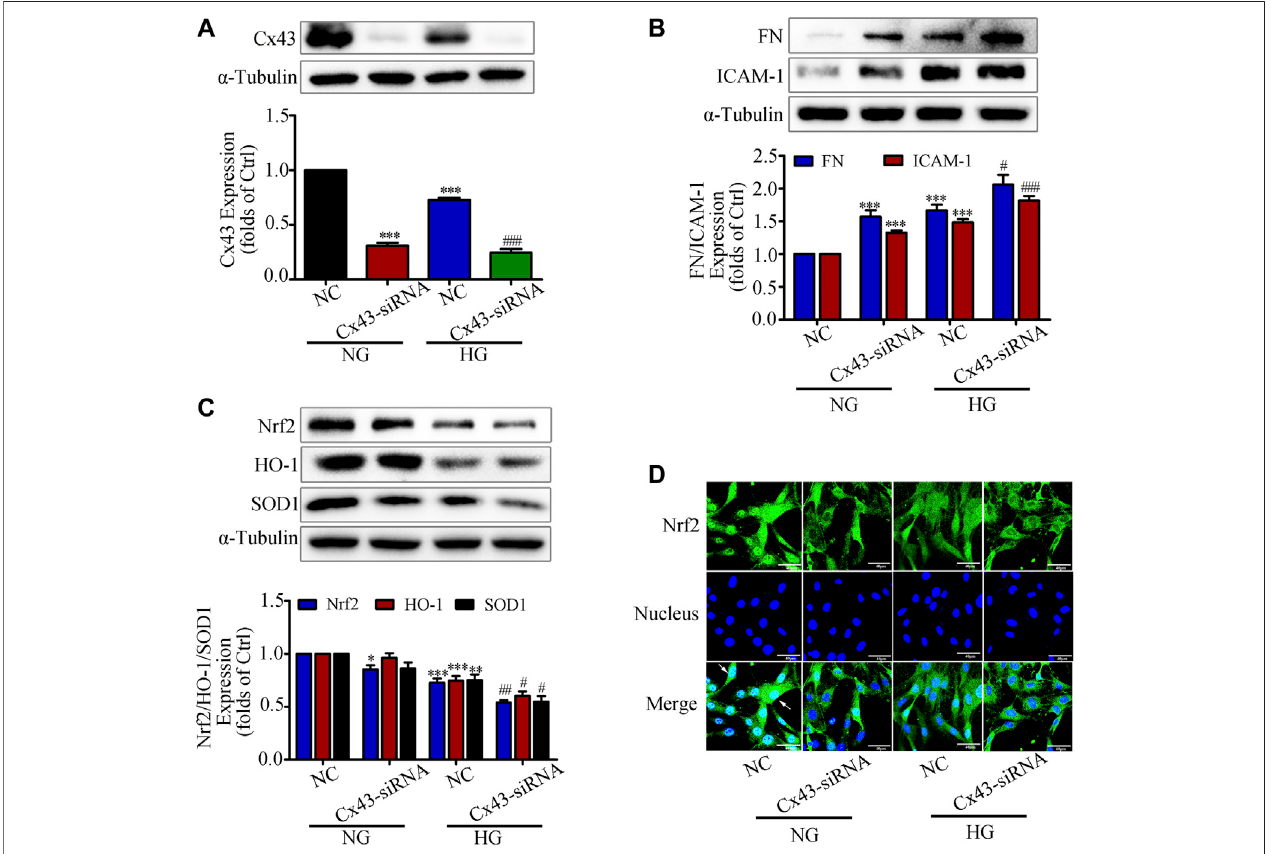
FIGURE 3 | Interfering with Cx43 attenuated high glucose induced activation of the Nrf2/ARE signaling pathway in GMCs. (A) The effects of Cx43-siRNA on Cx43 expression in GMCs under 30 mM HG (24 h) conditions was measured by the western blot assay. *** p < 0.001 vs . (NG + NC); ### p < 0.001 vs . (HG + NC). (B-C) The effectsofCx43-siRNAontheexpressionofFN,ICAM-1,Nrf2,HO-1,andSOD1wasinducedbyHG(30 mM,24 h).* p < 0.05,** p < 0.01,*** p < 0.001 vs .(NG+NC); # p < 0.05, ## p < 0.01, ### p < 0.001 vs . (HG + NC). (D) The subcellular distribution of Nrf2 in GMCs was measured by immuno fl uorescent staining under HG (6